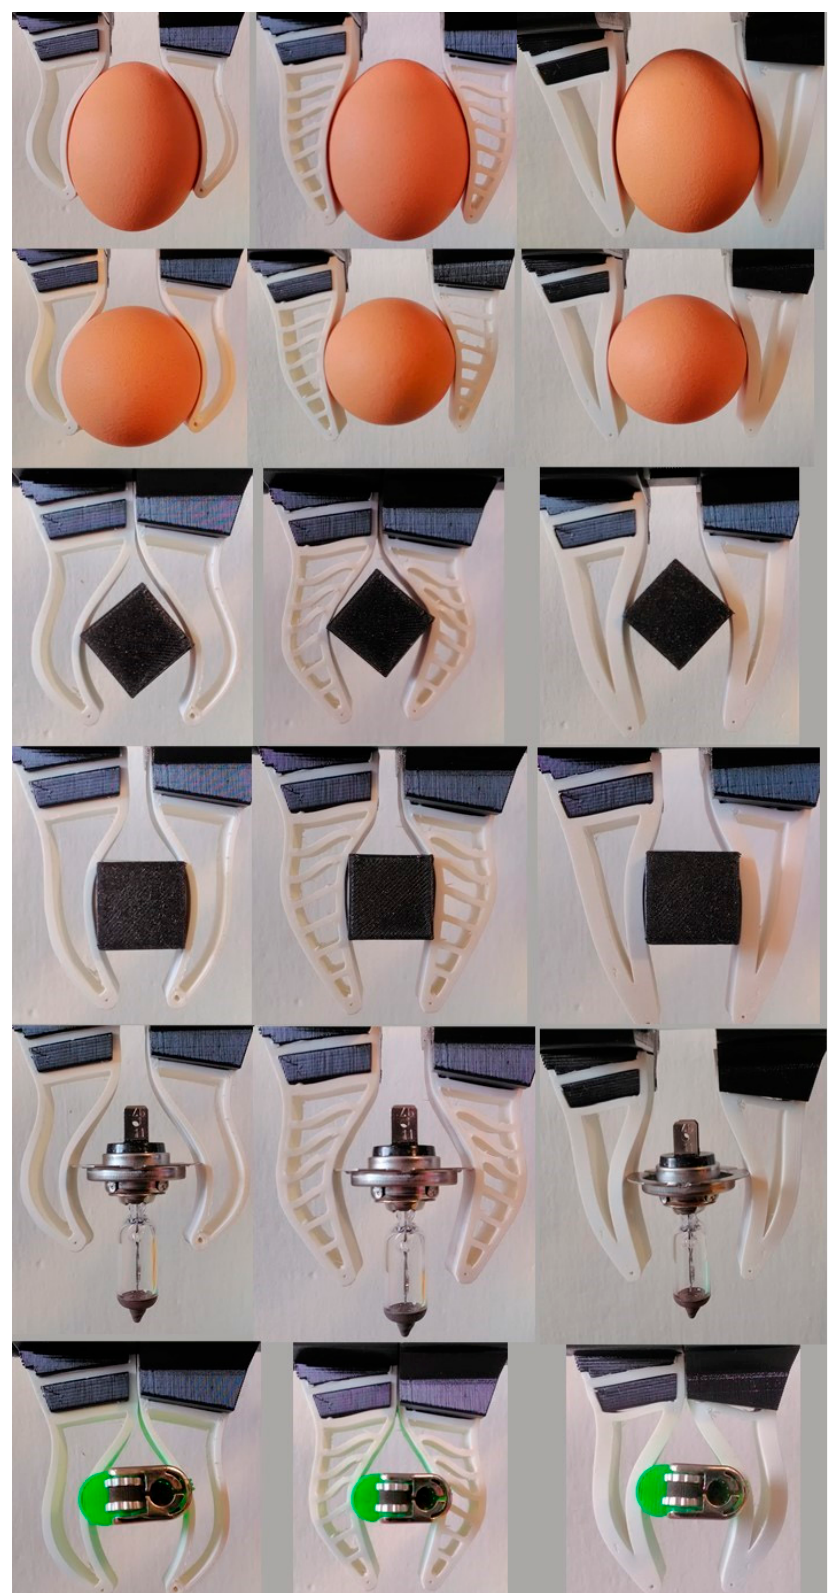
Figure 18. Demonstration of grasping various objects. Structures: left column—Structure B with a wall thickness of 1.6 mm; middle column—structure A with the number of ribs 6; right column— Structure B with a wall thickness of 4 mm.